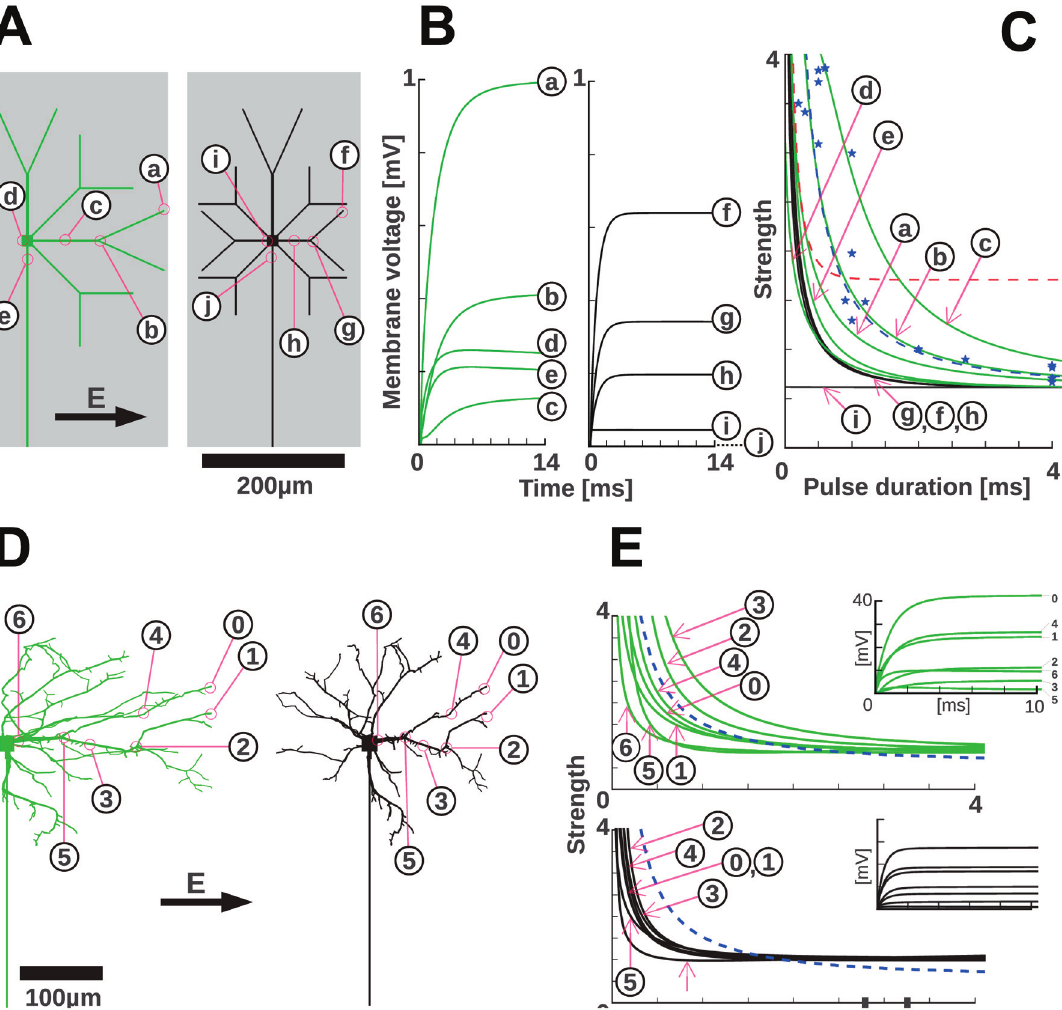
Fig 5. Simulations show that complex morphology and asymmetry dominate the charging kinetics in short neurites. (A) Model neurons featuring an extended dendritic tree that spreads out to cover the width of the structured substrate in the patterned cell cultures used in this study. Axons follow the direction of the strips (grey area) that denote the experimental line on which the neurons grow. The indicated positions within the dendritic tree are the locations for which charging kinetics and derived, normalized strength-duration plots are shown in B and C. If the soma is positioned at the center of a substrate strip, the dendritic tree can be left-right symmetric (black). For off-center locations, the arborization is asymmetric (green). (B) The charging kinetics for the models in A are shown. Symmetric dendritic trees lead to a faster charging kinetics: the soma is not charged and therefore no current flows into the axon. In the asymmetric case, longer dendrites occur (A left) and this favors slower charging kinetics. In addition, the soma is polarized and the resulting current flux into the very long axon contributes another slow timescale of charging (see panel G of S4 Fig). In A and B the tip segments a and f are the most depolarized, but their chronaxies do not match the experimentally observed ones. This could indicate that tip segments are not efficient in causing excitation of the cell. (C) From the charging curves in B normalized strength-duration curves are computed (see Materials and Methods). Corresponding to the uniformly fast charging of symmetric dendritic trees, the strength-duration curves are almost uniform throughout the arbor. Asymmetric arborization creates larger chronaxies. Blue stars and the dashed blue line represents the experimental data and fit for dendritic stimulation (i.e. perpendicular to lines) and the dashed red line the axonal stimulation fit for comparison (Fig 4). (D) A representative reconstructed cultured neuron (black, obtained from neuromorpho.org, Id: NMO_07978, from the dendritic arborization studies in primary cultures [52], and an asymmetric version (green) are used to obtain realistic charging curves for realistic dendritic trees. (E) The charging kinetics (insets) and the derived, normalized strength-duration curves for the reconstructed neuron. These confirm that in the absence of a pronounced lateralization (black) chronaxies are smaller than for pronounced left-right asymmetry (green). The chronaxie expected for dendritic stimulation of a realistic, asymmetric arbor falls in the range of observed chronaxies (dashed blue line). Symmetric dendritic trees would cause significantly shorter chronaxies.